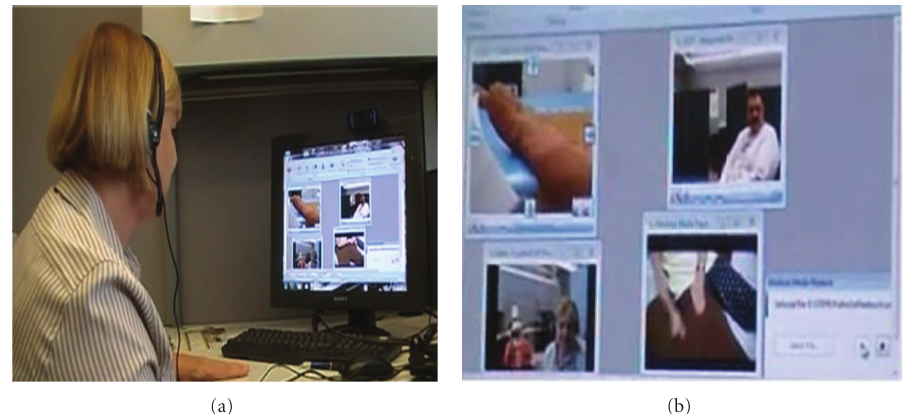
Figure 2: Remote clinician (a). Simulated telerehabilitation session (b). The right panel, top left, shows an image from video camera with remote control capabilities used for assessment; the right panel, top right, shows an image of a face-to-face intervention; the right panel, bottom left, shows an image of what the participant observes from their camera; the right panel, bottom right, shows educational video used for client